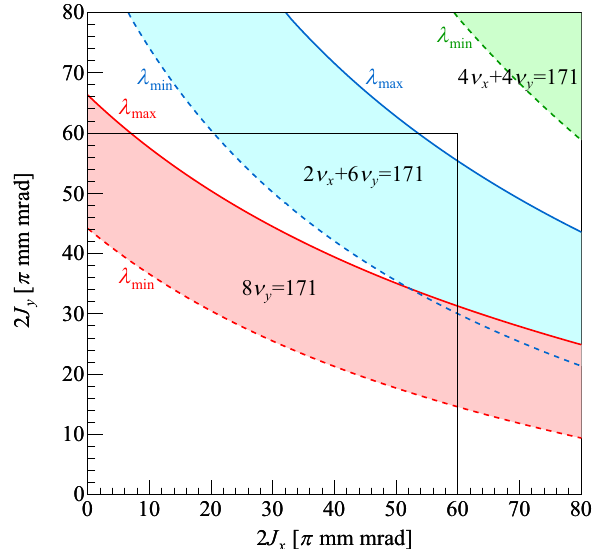
FIG. 5. The regions of actions influenced by the resonances from analytical calculations. The solid colored lines and dashed lines show the actions of the on-resonance particles ð J xR ; J yR Þ at λ ¼ λ , and λ ¼ λ , respectively. The red, blue, and green max min lines correspond to the resonances 8 ν y ¼ 171 ; 2 ν x þ 6 ν y ¼ 171 , and 4 ν x þ 4 ν y ¼ 171 , respectively. The two additional lines at 2 J x ¼ 60 π mm mrad and 2 J y ¼ 60 π mm mrad indicate the collimator